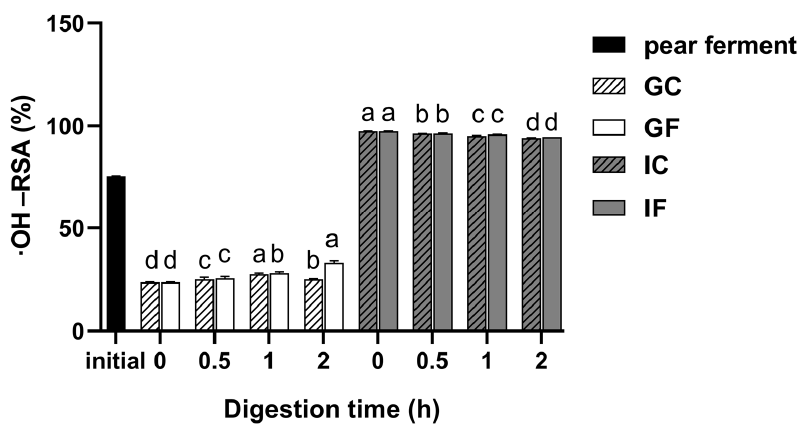
Figure 6. Changes of · OH-RSA of ‘Xuehua’ pear ferment during the simulated gastric and intestinal digestion in vitro. Different letters indicate significant differences in the same group under different digestion times ( p < 0.05). Data shown as means ± SD of three replicates ( n = 3).